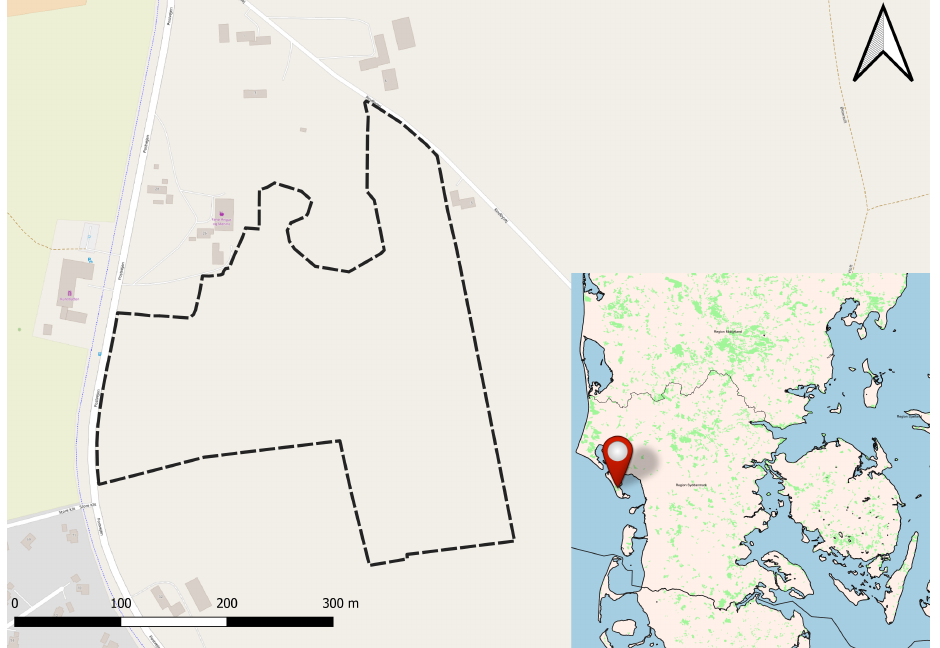
Figure 1. The island of Fanø located in the Wadden Sea of Denmark. The dashed black line represents the physical fence surrounding the 8.2 ha pasture. The coordinates of the upper left corner of the map frame are 55°25 (cid:48) 23.131 (cid:48)(cid:48) E 8°23 (cid:48) 53.531 (cid:48)(cid:48) N. This dataset includes Intellectual Property from European National Mapping and Cadastral Authorities and is licensed on behalf of these by